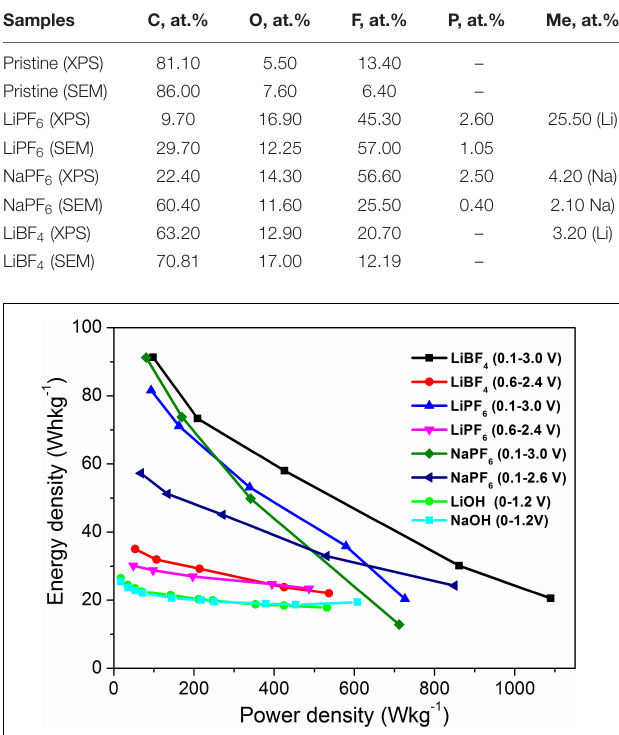
Frontiers in Materials |